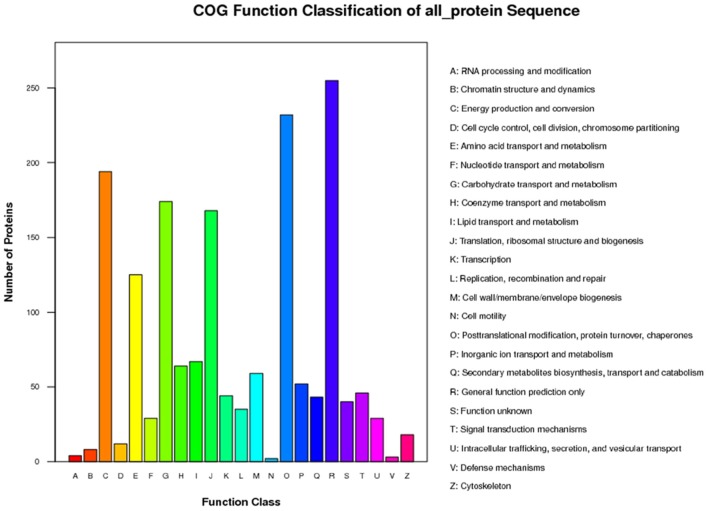
COG classification of all protein.